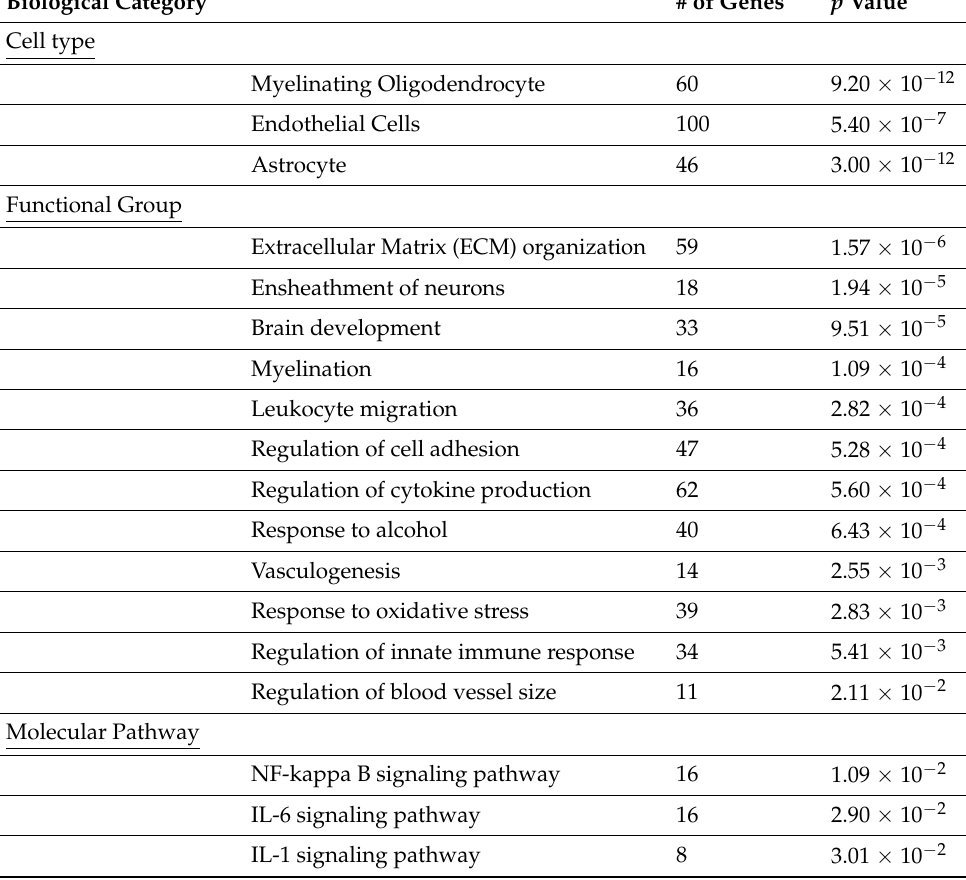
Table 1. Over-represented cell types and representative biological functional groups and molecular pathways. For a full list of over-represented functional groups and pathways, see Supplemental Table